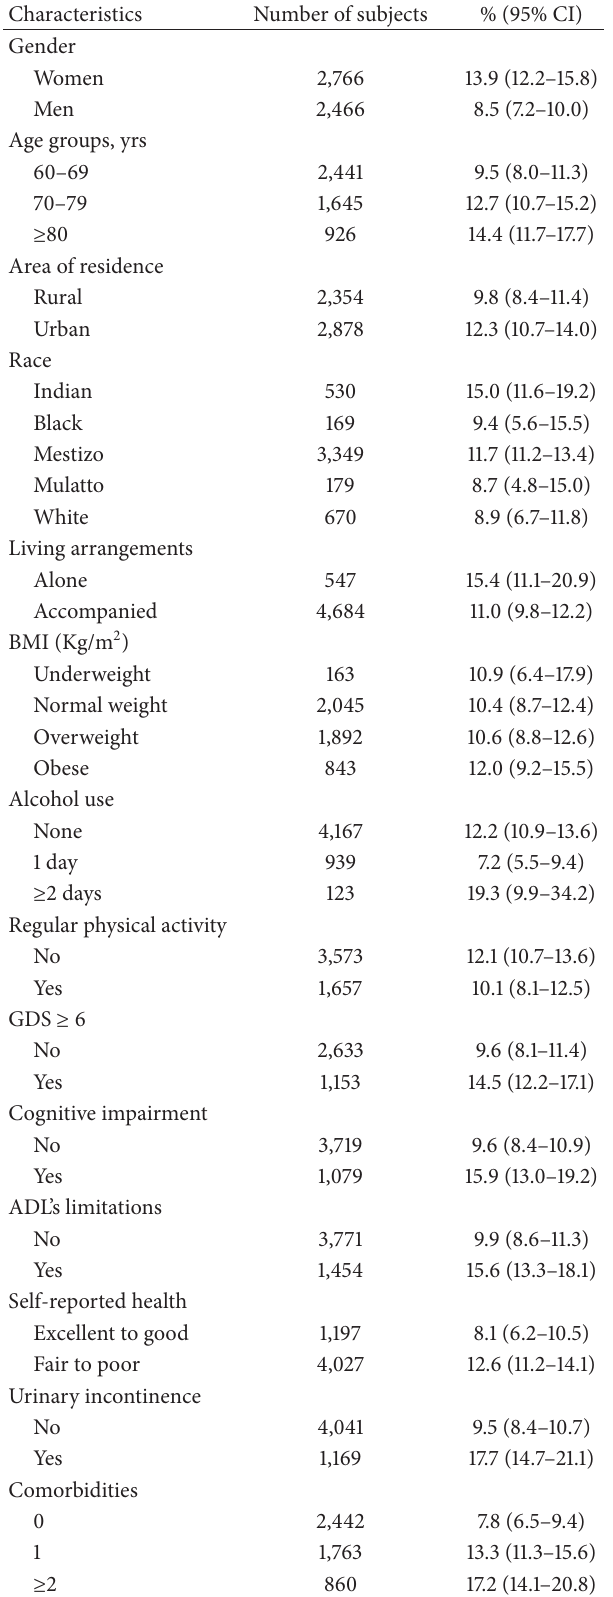
Table 1: Prevalence of fall-related injuries among older adults in